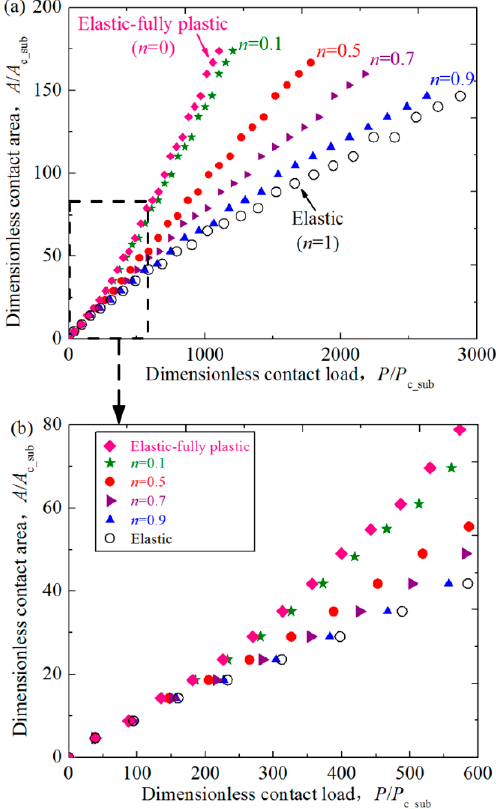
Figure 4. The relation between the dimensionless contact area A / A c_sub and load P / P c_sub for some typical cases where dimensionless coating thickness t / R = 0.01, Young’s modulus ratios E co / E su = 4 at different hardening exponents of the substrate n = 0.1, 0.5, 0.7, 0.9. The results for the purely elastic ( n = 1) and elastic fully-plastic ( n = 0) cases are also given. ( a ) 0 ≤ P/P c_sub ≤ 3000; ( b ) 0 ≤ P/P c_sub ≤ 600.